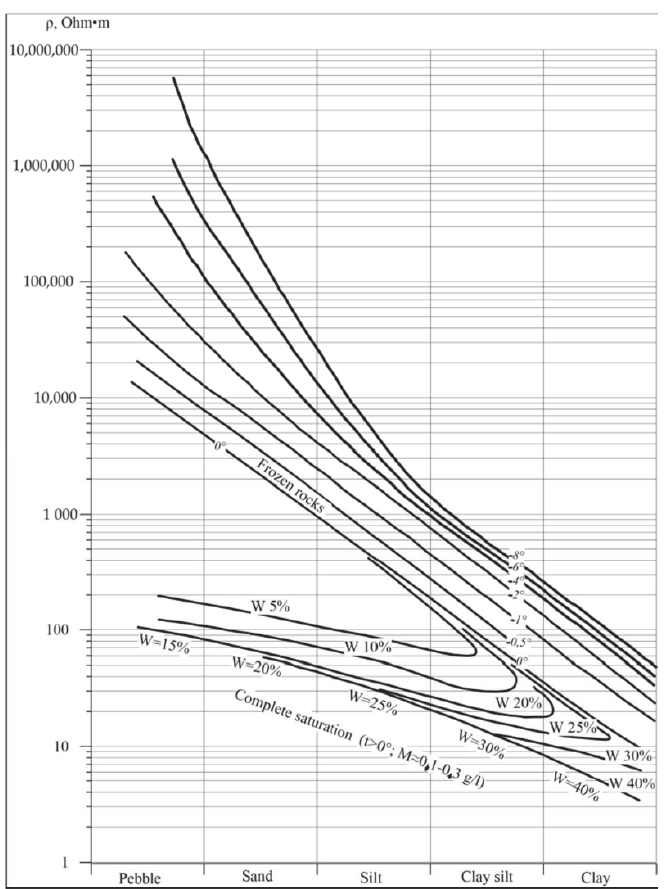
Figure 2. Chart of approximate temperature relations of resistivity for sediments of different lithology: frozen soft sediments with massive cryostructure and water-bearing unfrozen sediments, with saturation from 5% to complete [3].